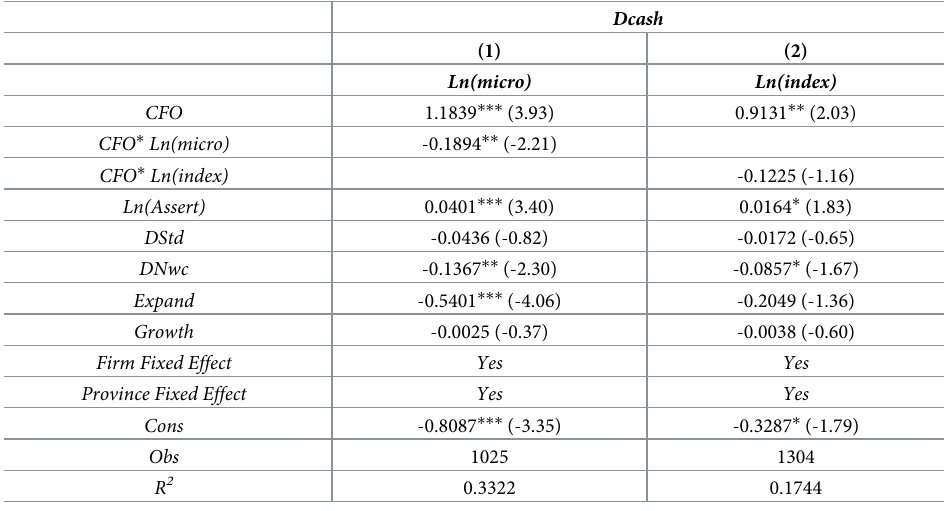
Table 8. Empirical results of fiscal and financial policies for small (micro) enterprises to alleviate financing